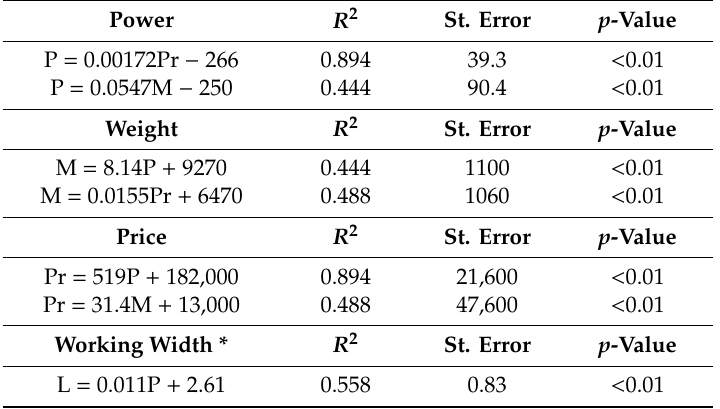
Table 4. Linear models for technical parameters and prices of forage harvesters. Power R 2 St. Error p